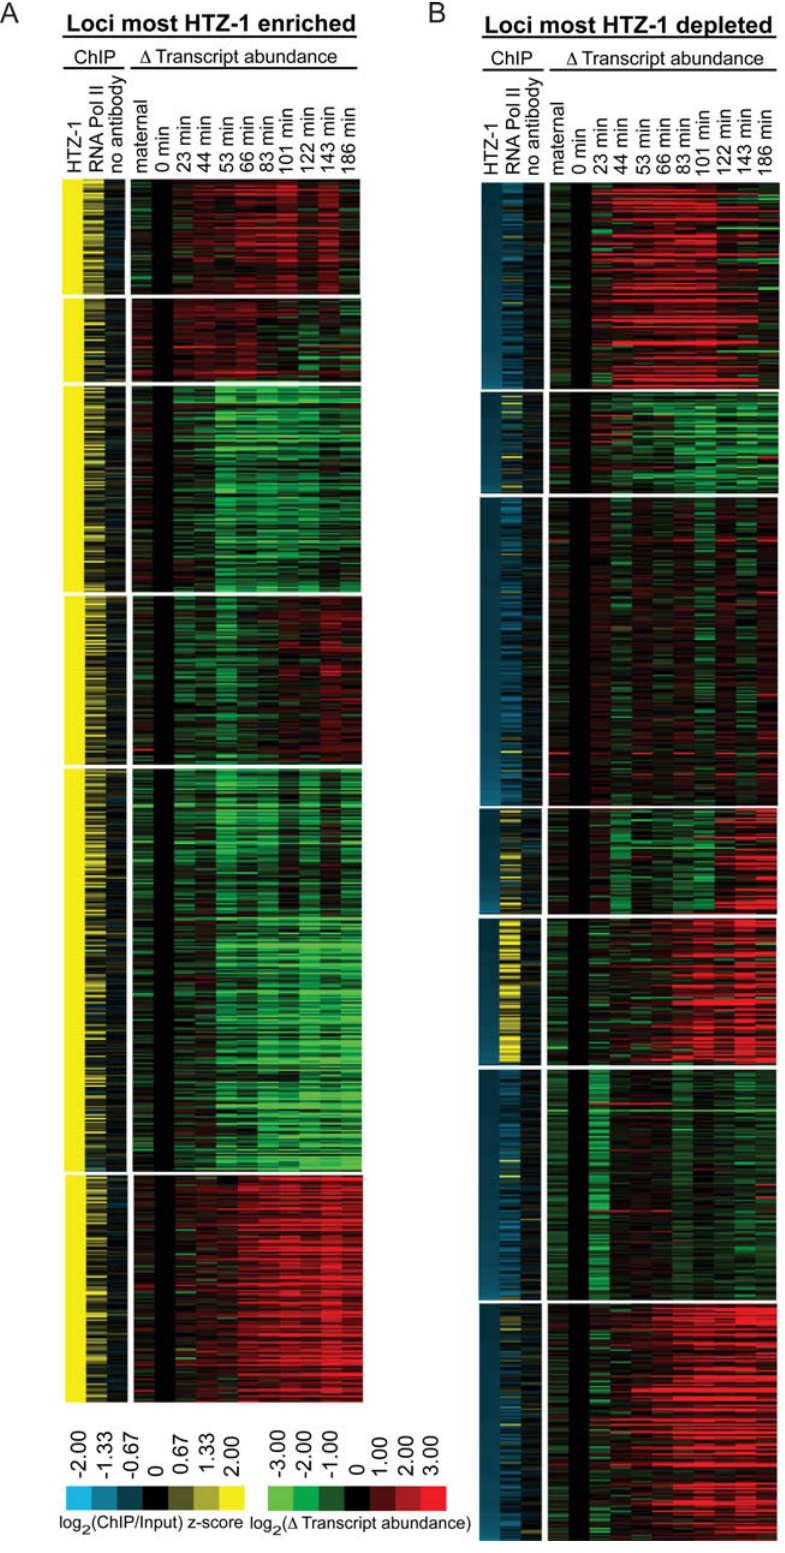
Figure 6. Genes downstream of HTZ-1 occupied promoters do not conform to a stereotypical expression pattern. (A) HTZ-1 occupancy at promoters was scored by averaging z-score ChIP values for all probes within 1 kb of the translation start site. Gene promoters with average z-scores greater than two were compared with a published expression dataset and are shown [31]. For each timepoint, the log 2 of change in transcript abundance (timepoint/4-cell embryo) is shown. Genes with high maternal transcript abundance (absolute transcript abundance . 100) were removed from analysis. K-means (k=6) cluster analysis was performed with Cluster [78] using spearman rank correlation as a distance metric with 1000 iterations and visualized with Treeview [79]. (B) Same as A, but for promoters lacking HTZ-1 (z-score ,2 0.87).